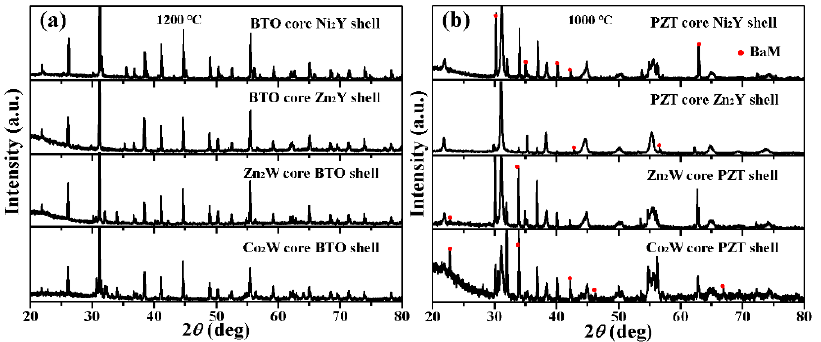
Figure 6. The XRD θ –2 θ patterns for ( a ) BTO core–Ni 2 Y/Zn 2 Y shell and Zn 2 W/Co 2 W core–BTO shell fibers annealed at 1200 °C, and ( b ) PZT core–Ni 2 Y/Zn 2 Y shell and Zn 2 W/Co 2 W core–PZT shell fibers annealed at 1000 °C. The red dot shows the peaks of impurity phase BaM.